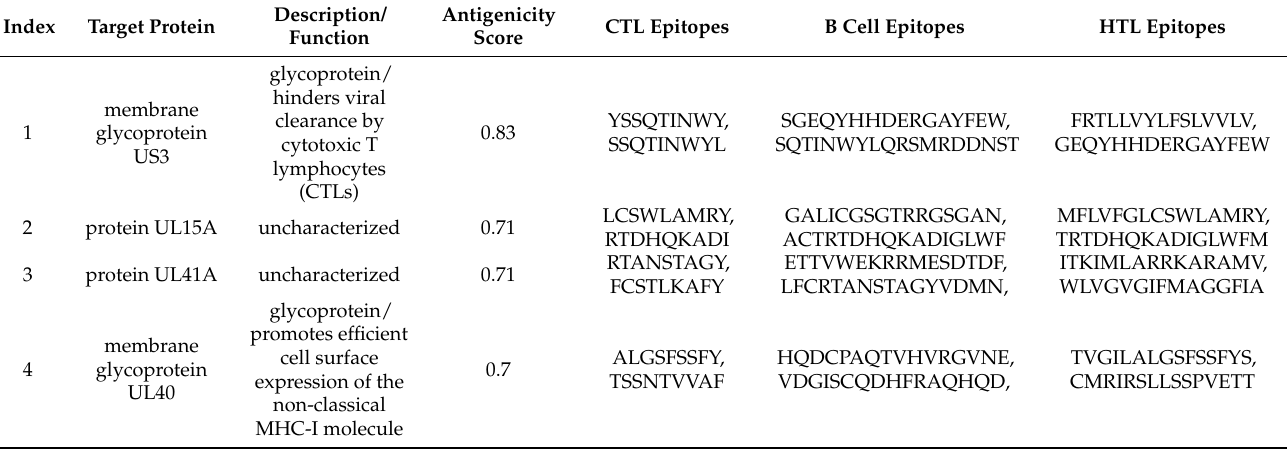
Table 1. Shows the details of target proteins and the amino-acids sequences of different epitopes (CTL, B cell and HTL) used in the design of MEVCs against the four highly antigenic proteins of HCMV.